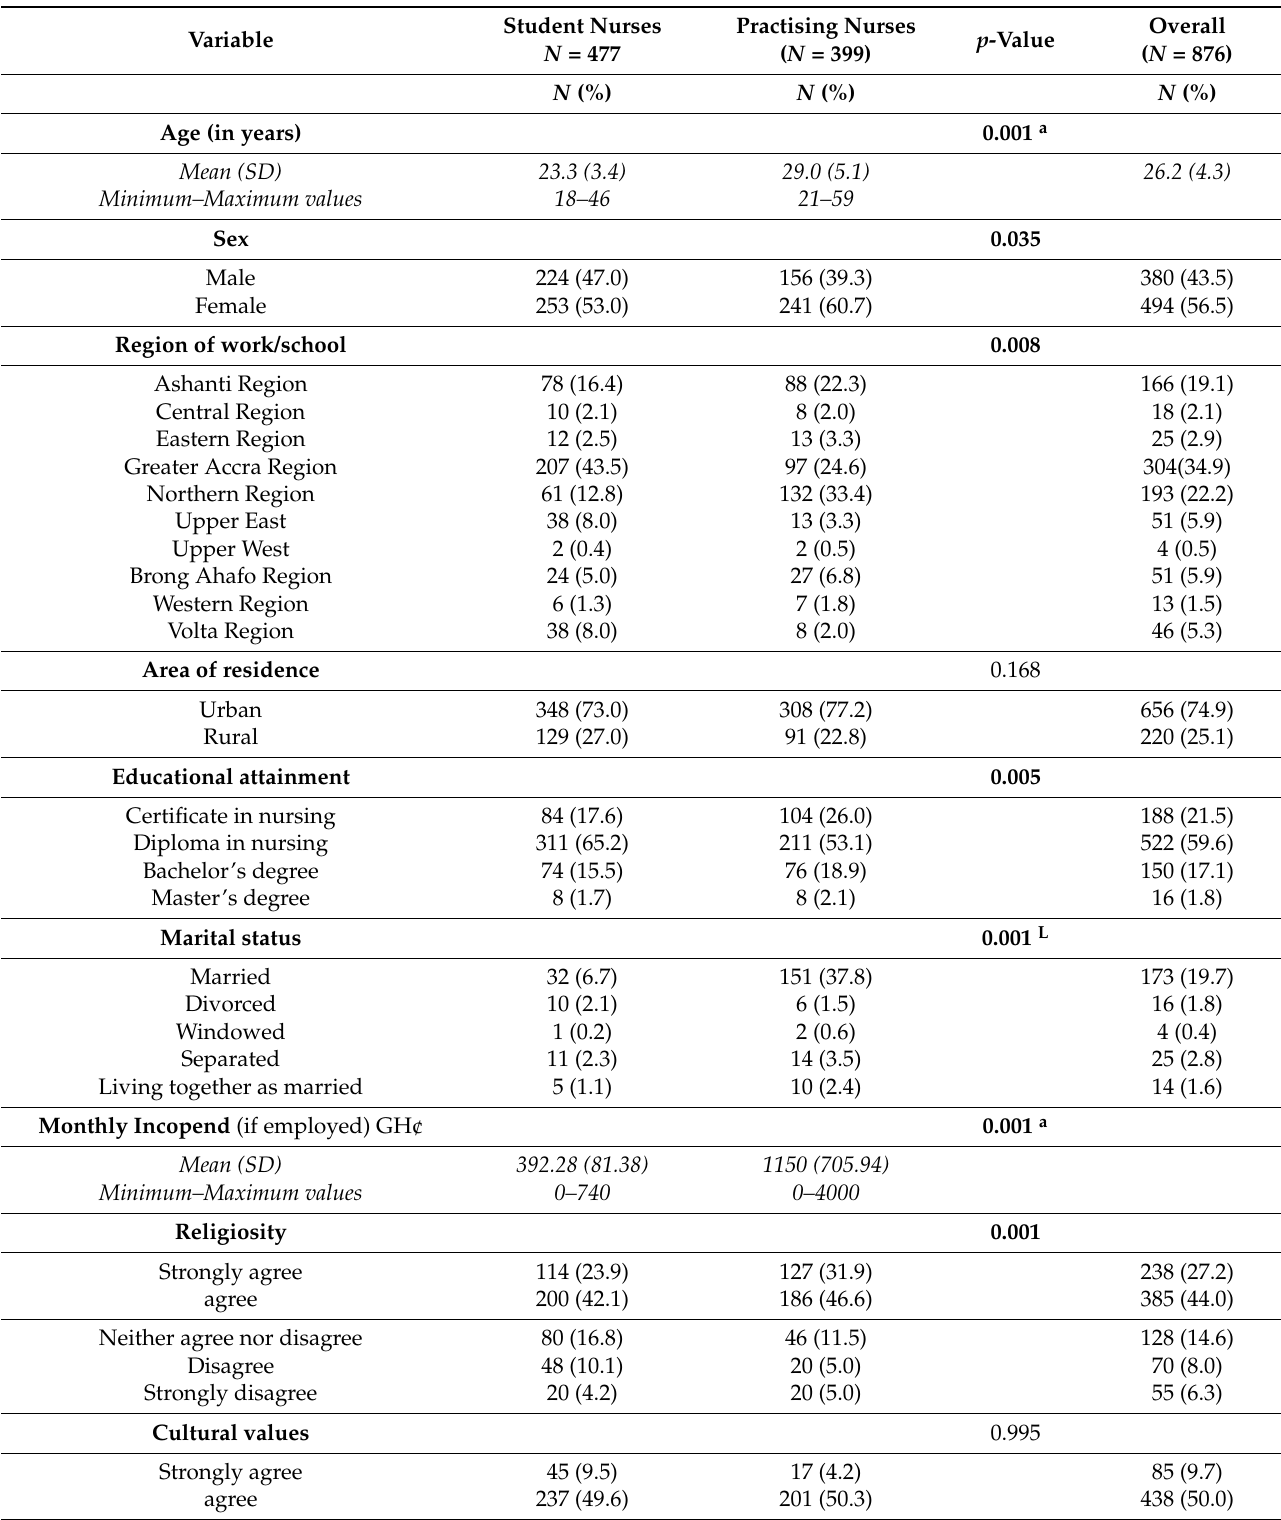
Table 1. Descriptive statistics and differences between student and practising nurses as regards the variables included in the study by Chi-Square analyses #